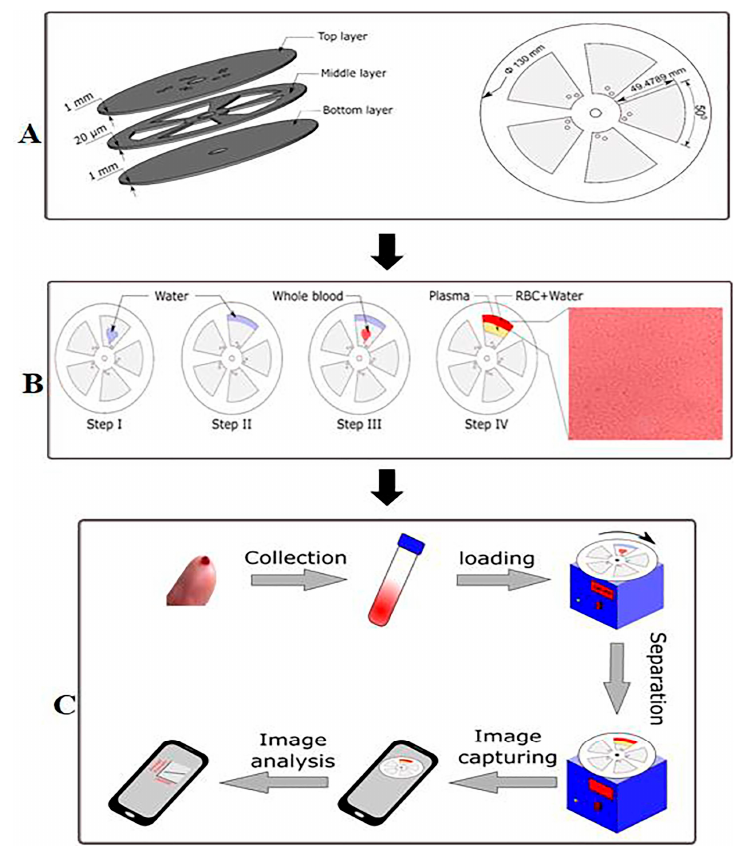
Figure 2. Representation of the experimental process. ( A ) Design and specifications of the compact disc. Side view of the device showing thicknesses of the top, middle and bottom layers which are 1 mm, 20 µm, and 1 mm, respectively. The top view of the compact device showing the channel length which is 49.4789 mm, the angular span of each sector which is 50°, and the diameter of the disc which is 130 mm. ( B ) Stepwise procedure of sample processing in the spinning disc. Loading of DI water in the microchannel (Step I); rotating the disc (at 1000 rpm for 1 min) for transporting water to the outer periphery of the microchannel (Step II); loading of whole blood in the same channel (Step III); rotating the disc (at 2000 rpm for 13 min) to accomplish the separation of RBC from whole blood (Step IV) and mixing with DI water. A magnified view of the RBC lysis in a microchannel is shown as a blown-up figure. ( C ) Schematic illustration of the process flow of Hb estimation in the present POC device. The essential steps include a collection of finger pricked blood into a tube pre- coated with an anti-coagulant, loading of blood in the micro-channel of the disc, separation of RBC due to centrifugation, and mixing with DI water. The rotational speed is displayed using a display unit to attain a precise setting. After osmotic hemolysis leading to the release of Hb, the colored image is captured using a smartphone for rapid analysis. Reprinted with permission from [20]. Cop- yright 2021 Elsevier.